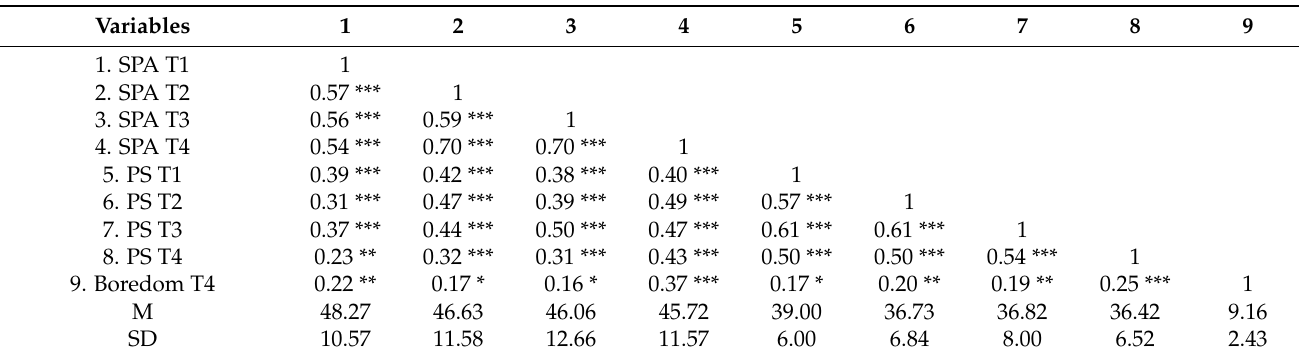
Table 1. Pearson correlation coefficients, mean (M), and standard deviation (SD) for the measured